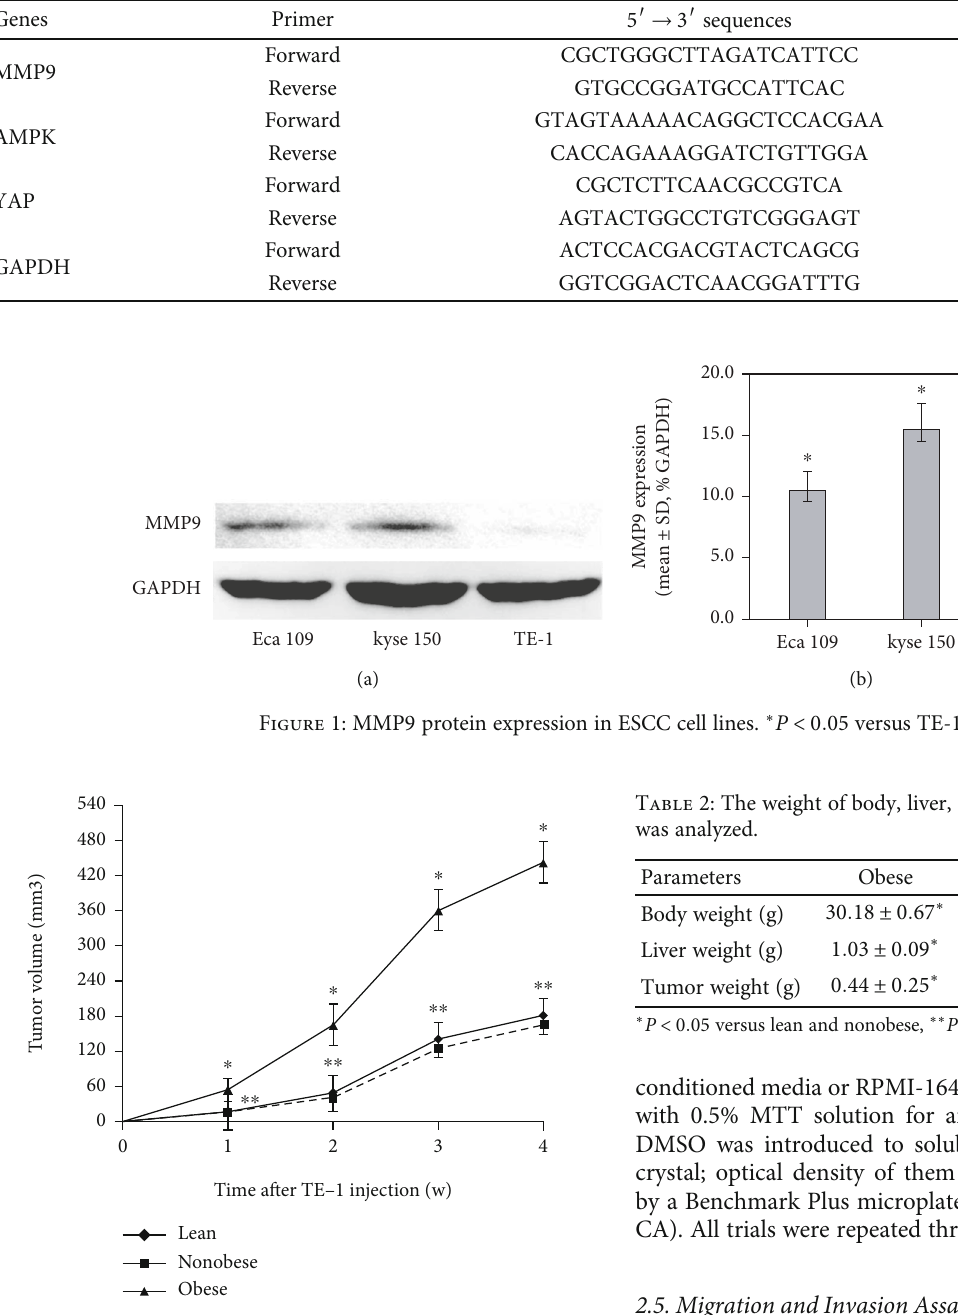
Figure 2: Subcutaneous tumor xenograft growth curve. Tumor xenografts from obese nude mice grew faster than those from lean and nonobese animals within 4 weeks. ∗ P < 0 : 05 versus lean and nonobese, ∗∗ P > 0 : 05 versus nonobese.